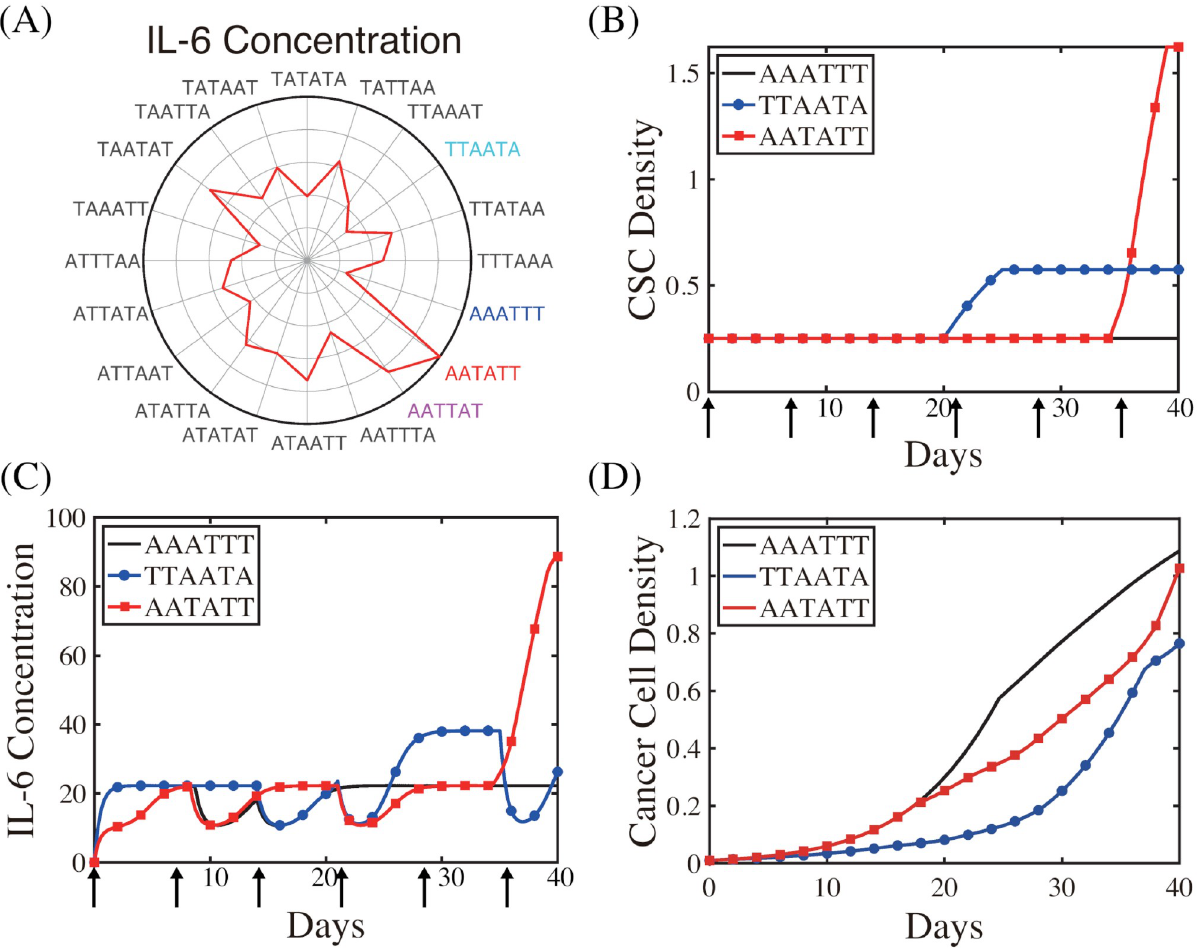
Fig 13. Optimized schedule: Preventing CRCC and minimizing anti-tumor efficacy. (A) Polar representation of the normalized IL-6 levels at t = 40 days corresponding to the different alternating schemes of TZB and ATV. (B-D) Time courses of the CSC density (B), IL-6 concentration (C), and cancer cell density (D) corresponding to the best (‘ AAATTT ’) and worst (‘ AATATT ’) scheme in preventing CRCC and the best (‘ TTAATA ’) scheme in minimizing both tumor volume and IL-6 level. Parameters: I